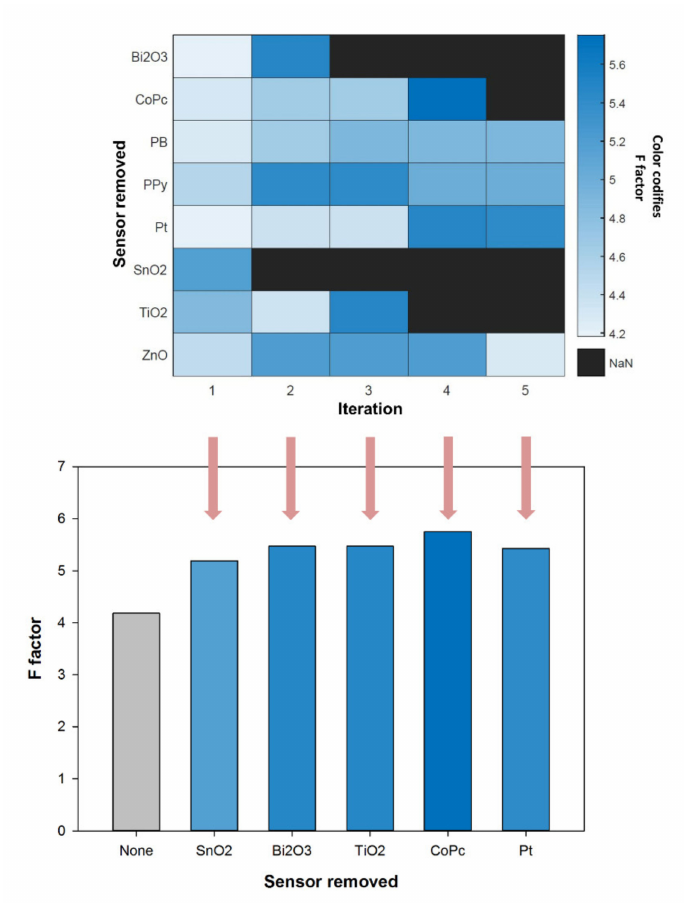
Figure 3. (Top) Color map of the variation of the F values after iterative exclusion of the di ff erent electrodes; the Y-axis shows the sensor being left out for the calculation of the F factor and the X-axis shows the successive iterations for the selection of the less significant sensor. (Bottom) Bar plot of the changes of the F values after exclusion of the sensor that leads to the biggest F value at each iteration. In both cases, the color of the plot codifies the F factor values as per the color bar. Iteration 5 does not produce any further improvement, and then the process is stopped.